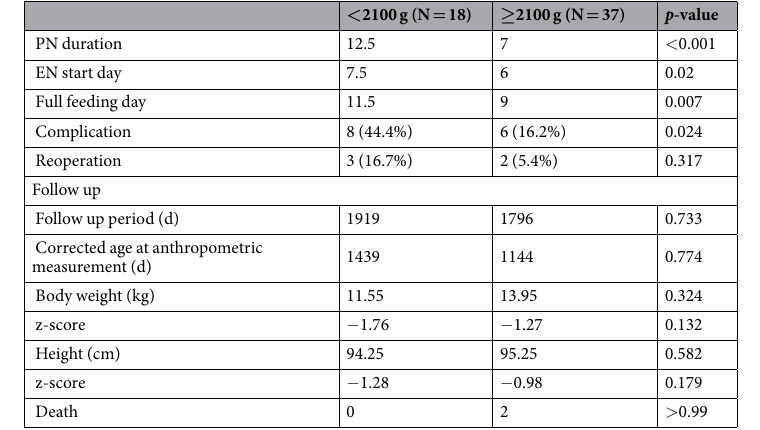
Table 5. Comparison according to body weight. NEC: necrotizing enterocolitis, SIP: spontaneous intestinal perforation, MRI: meconium-related ileus, MNRI: meconium non-related ileus, RDS: respiratory distress syndrome, PDA: patent ductus arteriosus, ROP: retinopathy of prematurity, PN: parenteral nutrition, TPN: total parenteral nutrition, EF: enterostomy formation, WBC: white blood cell, Hb: hemoglobin, EBL: estimated blood loss, EN: enteral nutrition.